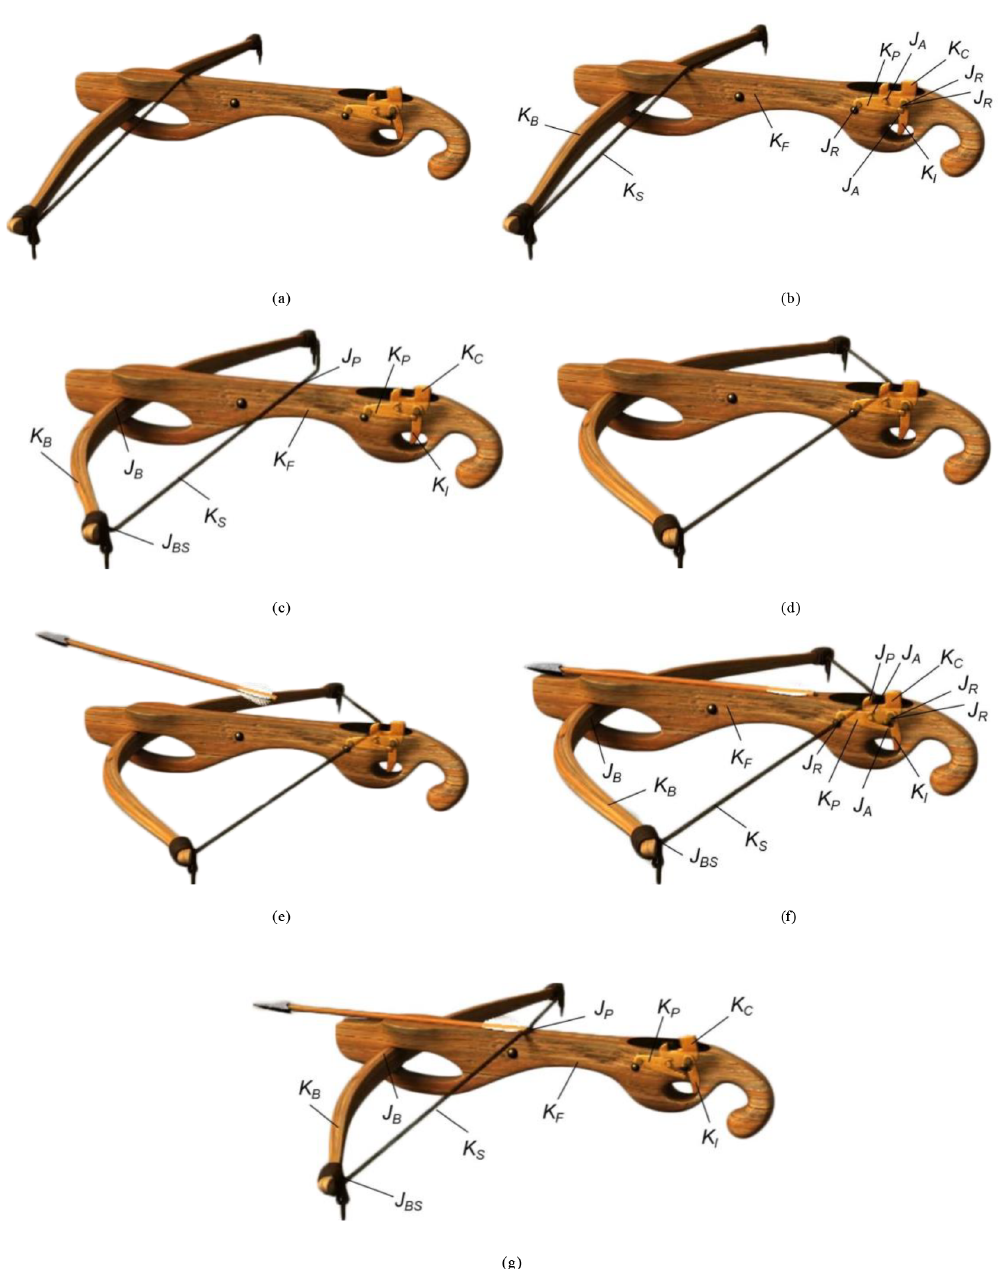
Figure 3. Shooting process of the original